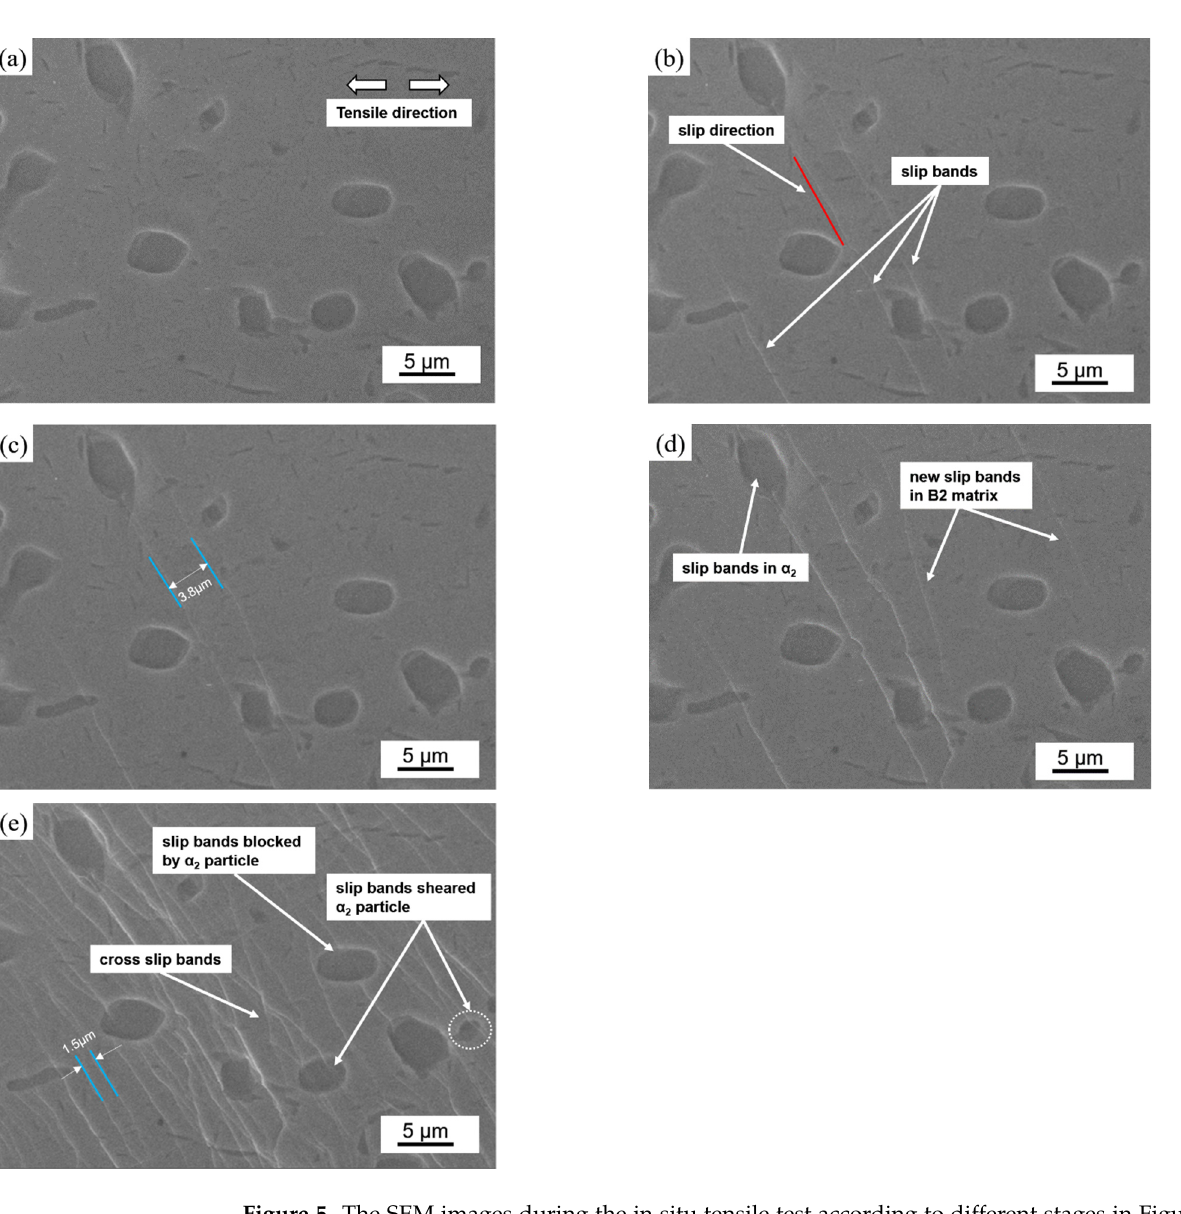
( a ) 1st, ( b ) 2nd, ( c ) 3rd, ( d ) 4th and ( e )